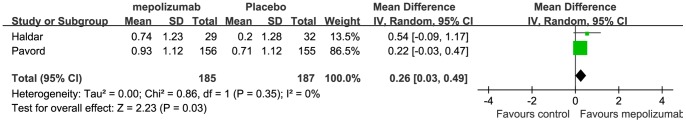
The effects of mepolizumab on Asthma Quality of Life Questionnaire (AQLQ).